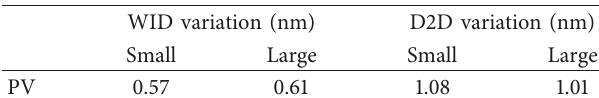
Figure 2: The trimming power with temperature drift. Table 2: PV